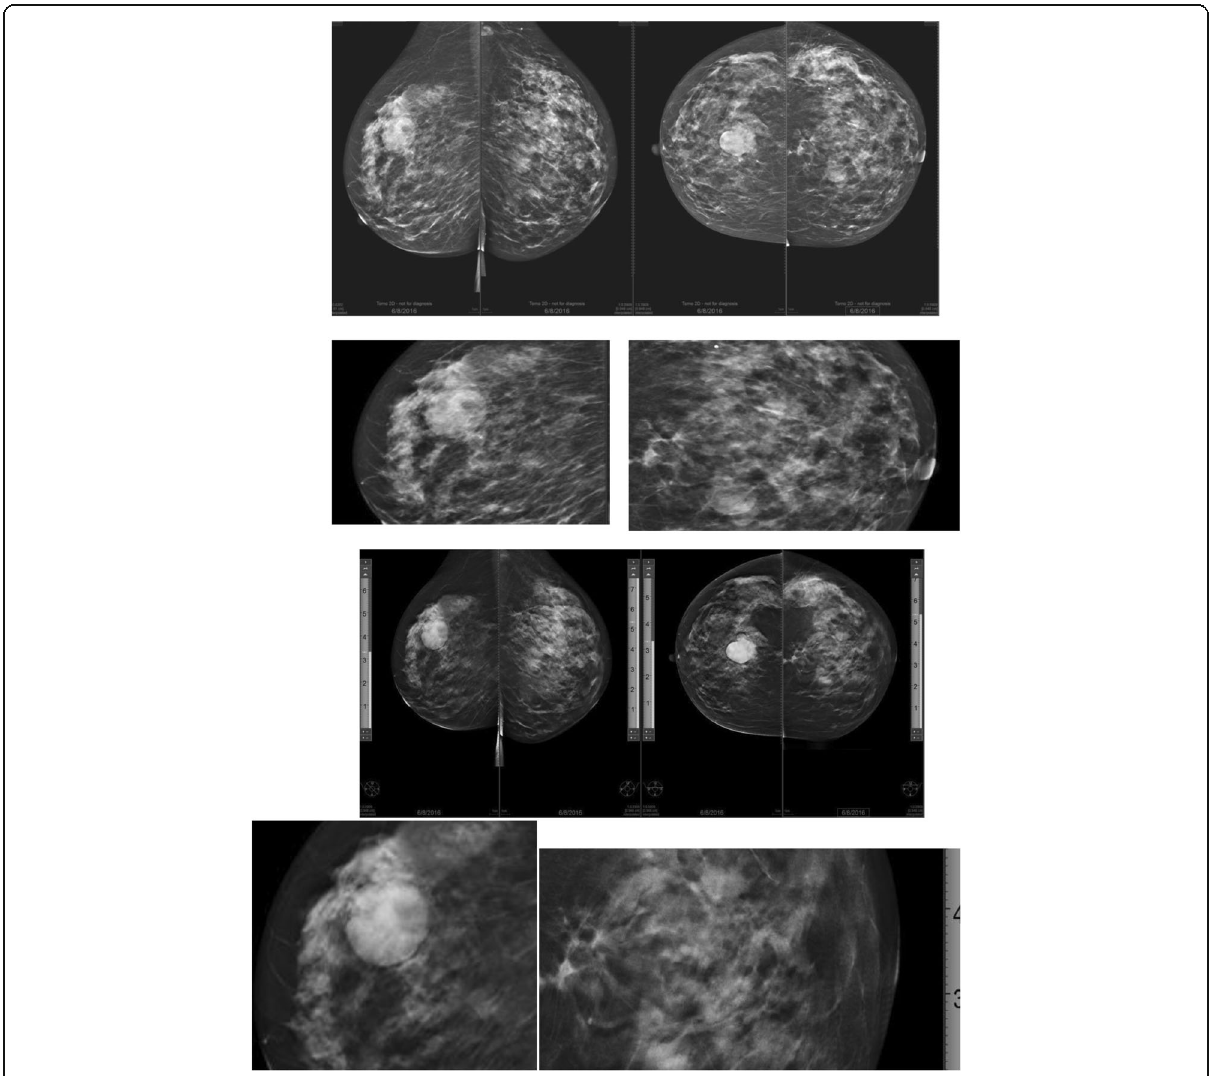
Fig. 4 Sixty-five-year-old female mammography CC and MLO views ACR C .Bilateral central partially well-circumscribed partially obscured dense lesions, BIRADS 3. Lt upper central and UOQ area of focal asymmetry and architectural distortion, BIRADS 3. Tomosynthesis CC and MLO views right central rather well-circumscribed dense lesion, BIRADS 2. Left upper central irregular speculated lesion BIRADS 4C. 3D digital breast tomosynthesis easily detected the lesion and this changed the BIRADS from 3 to 2, proved by US to be cyst, tomosynthesis upgraded the